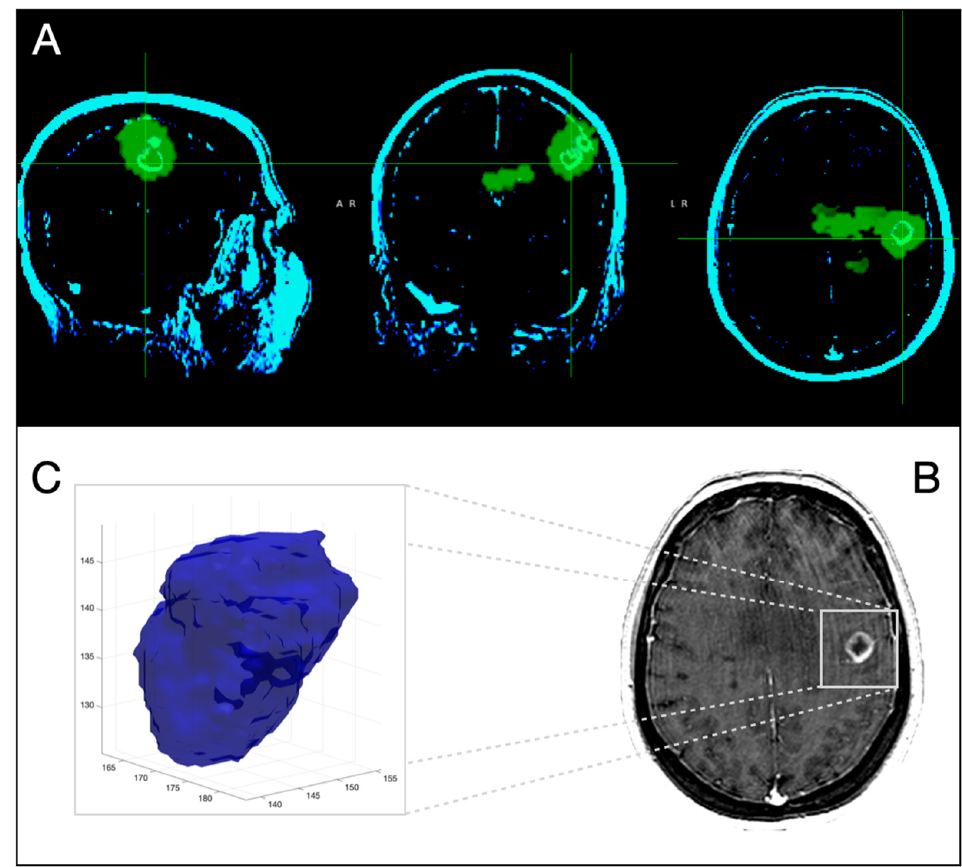
Figure 2. Three-dimensional corregistration of MRI T1-Gd with 18 F-Fluorocholine PET for the same patient as in Figure 1. Axial, coronal and sagittal slices representative of PET (green) and CE-MRI (light green) ( A ) Representative axial slice of CE-MRI ( B ). Three-dimensional representation of segmented CE-tumor on MRI ( C ).